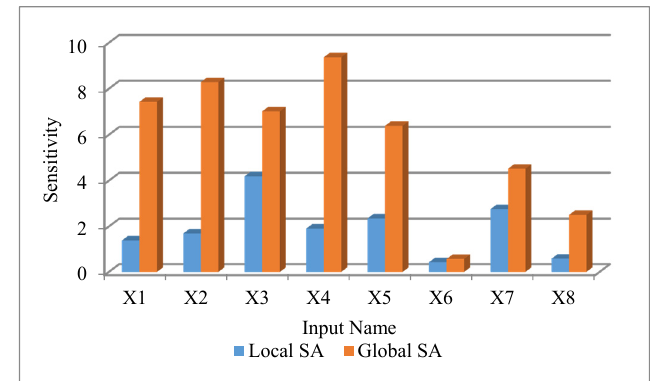
Figure 9. Comparison of local and global sensitivity for HL.